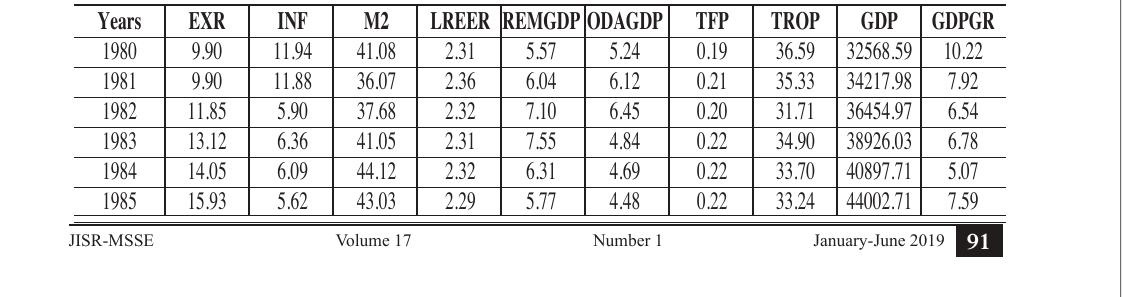
Data for Original